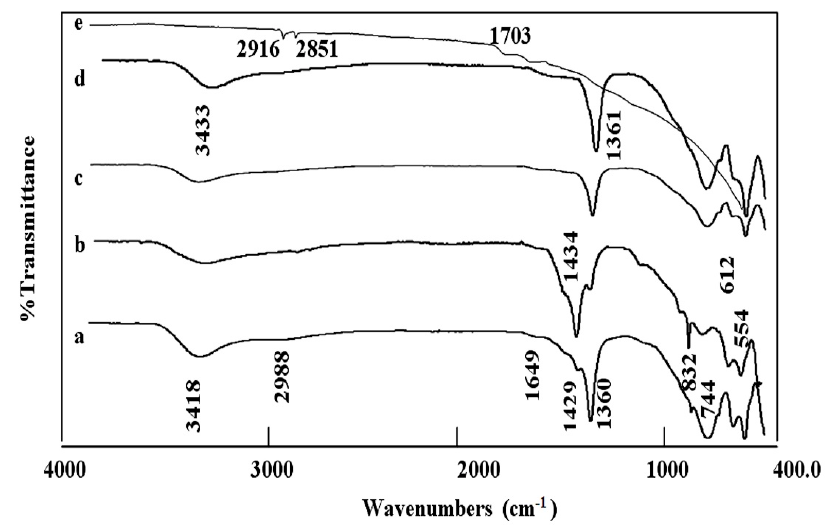
Figure 3. FT-IR spectra of: ( a ) Zn-Al LDH, ( b ) Zn-Al-GO1, ( c ) Zn-Al-GO2, ( d ) Zn-Al-GO3 and ( e ) The prepared graphene.